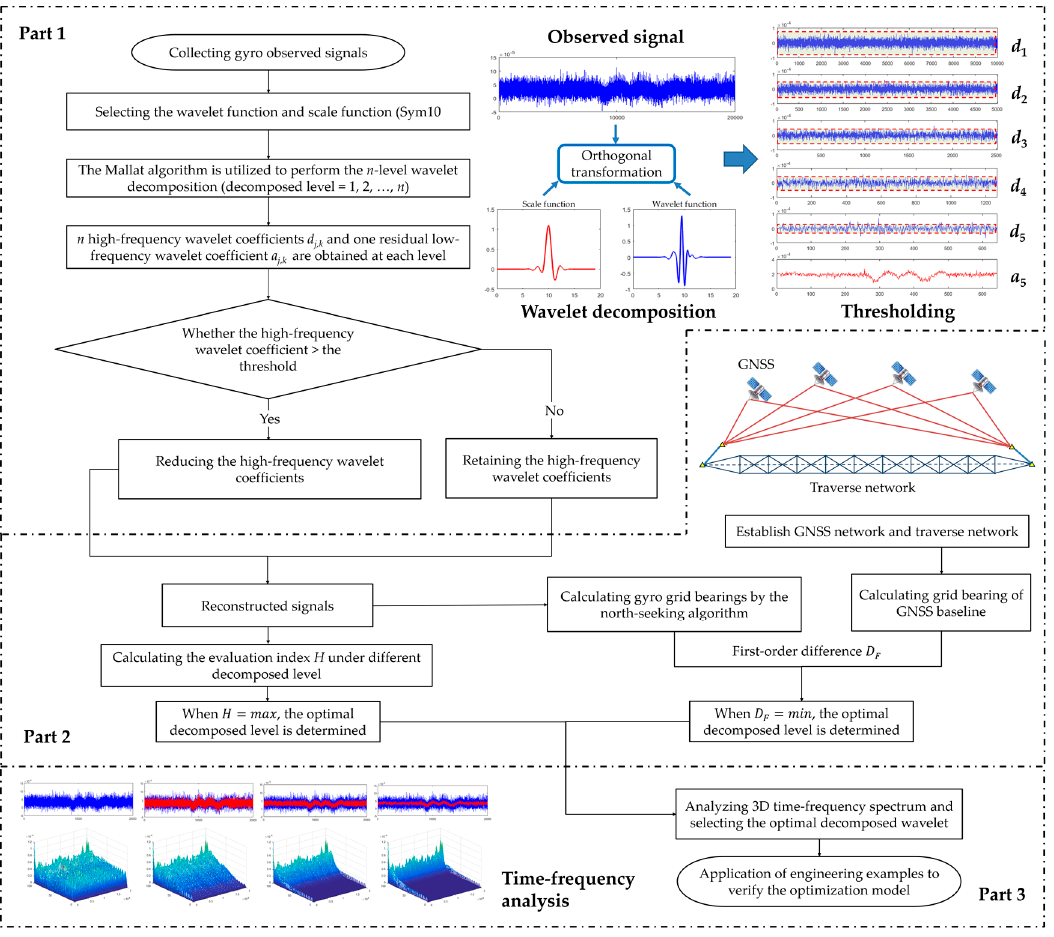
Figure 2. The flow chart of the experiment of the optimal wavelet decomposed level.